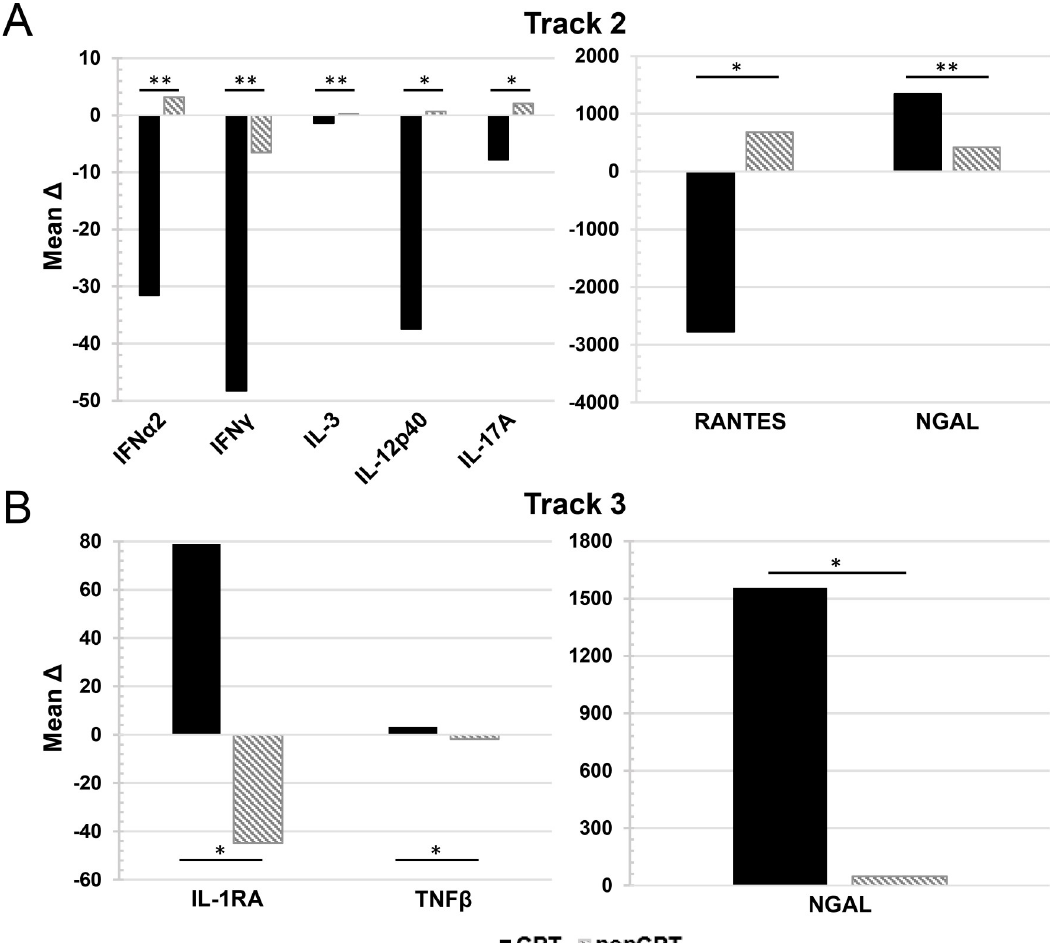
Fig 7. Mean change in concentration from pre-infusion to Day 10 post-infusion of patients with and without CPT. The mean change ( Δ ) in cytokine concentration between pre-infusion levels (Day 0) and Day 10 post-infusion for CPT patients and corresponding10-day period for nonCPT treated patients were calculated in patients categorized as Track 2 (A) and Track 3 (B). Statistically significant changes in mean values between those patient who received CPT (Track 2, n = 22; Track 3, n = 10) and those who did not (nonCPT; Track 2, n = 8; Track 3, n = 10) were evaluated via T-test. Significance is denoted by ( � ) for 0.01 � p � 0.05 or ( �� ) for p <